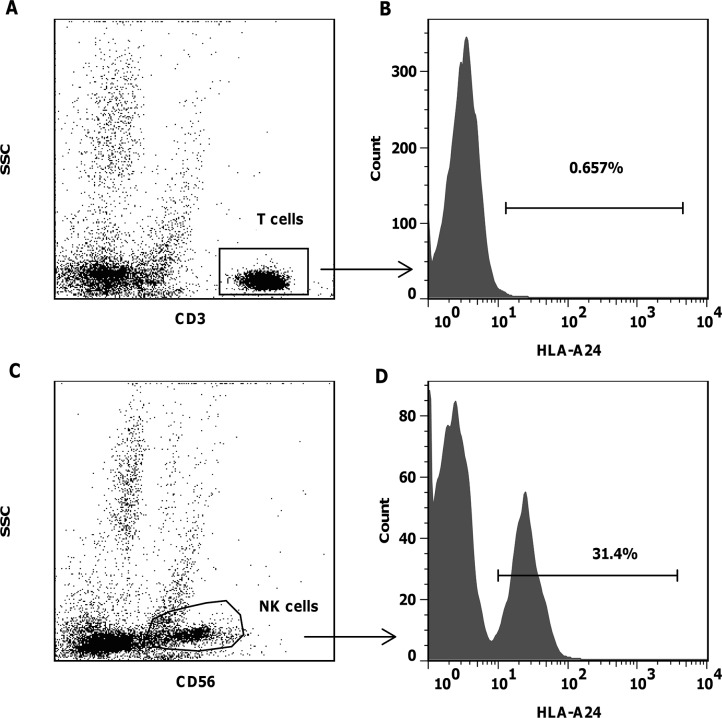
Detection of donor NK cells in bone marrow.A single bone marrow aspirate taken from Patient 03 48 days after receipt of a second infusion of primed donor NK cells showed absence of HLA-A24+ donor T cells (A and B). Donor NK cells (C) expressing HLA-A24 represented almost 1/3 of the total NK cells in the bone marrow (D).